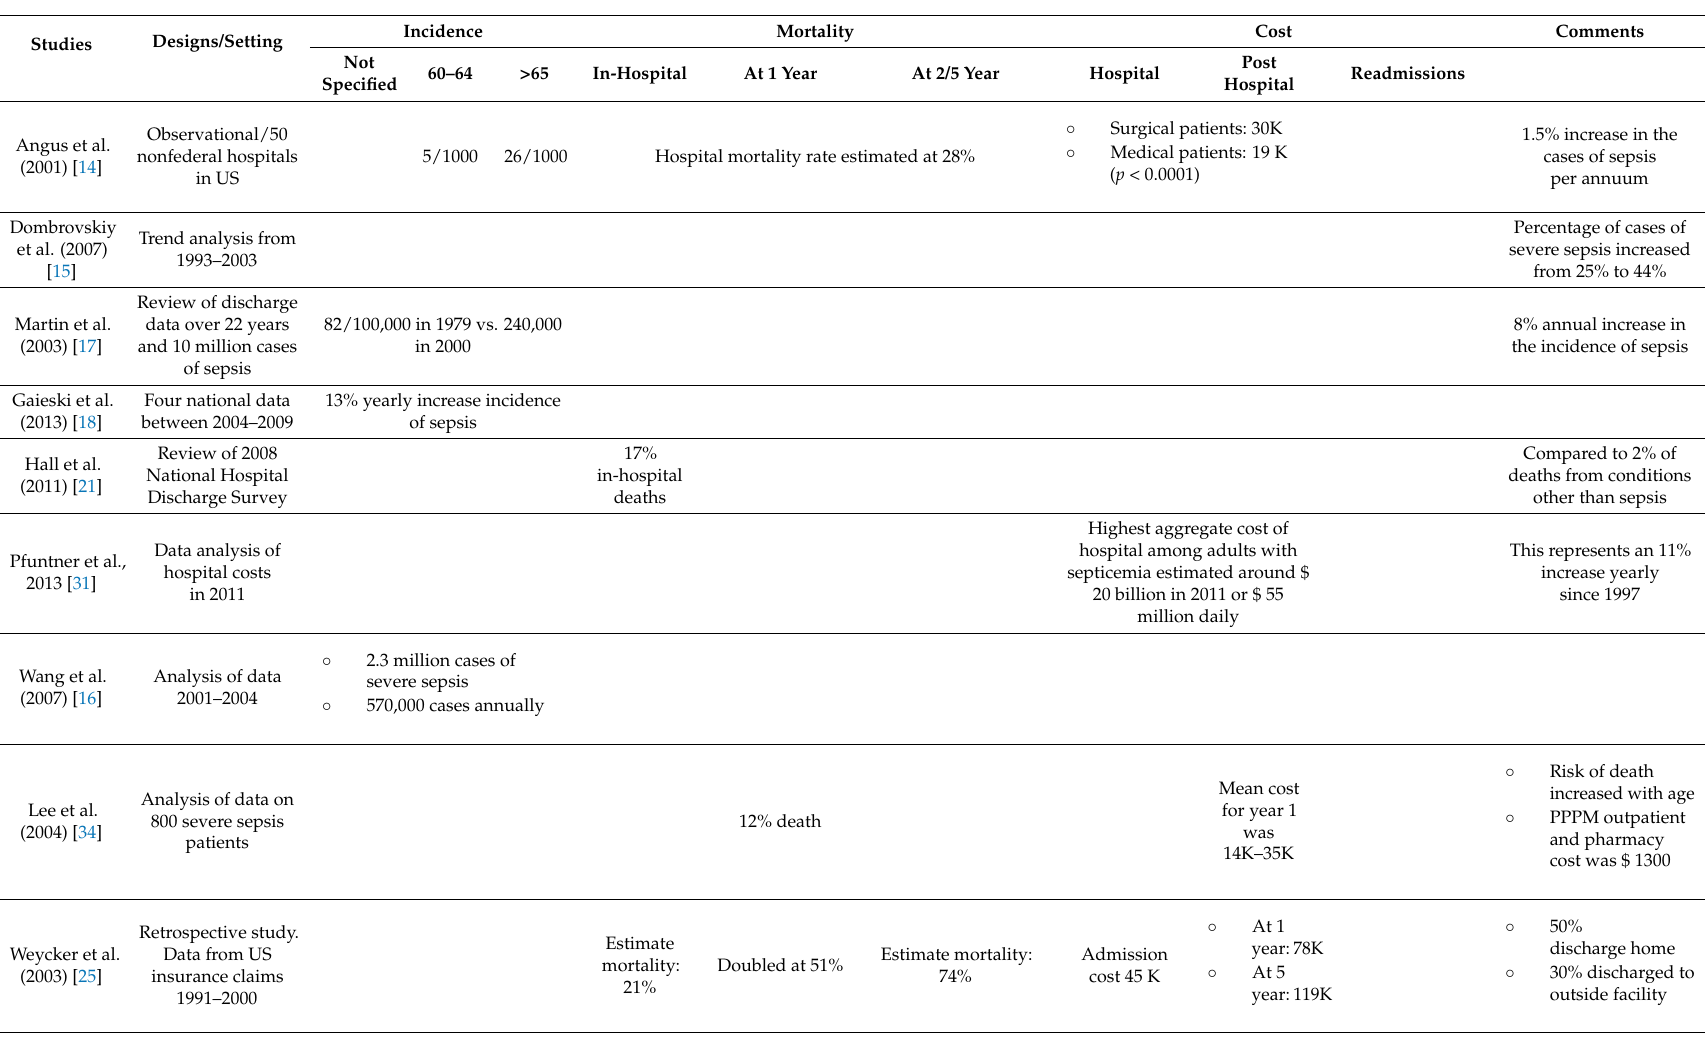
Table 1. Review table of literature review